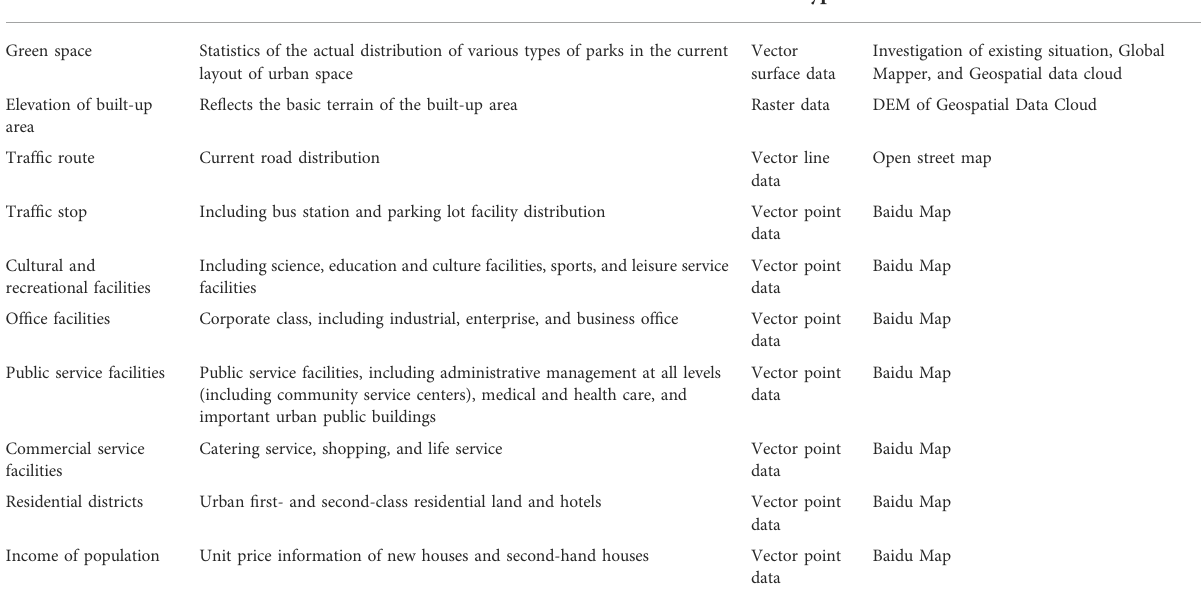
TABLE 1 Description of POI